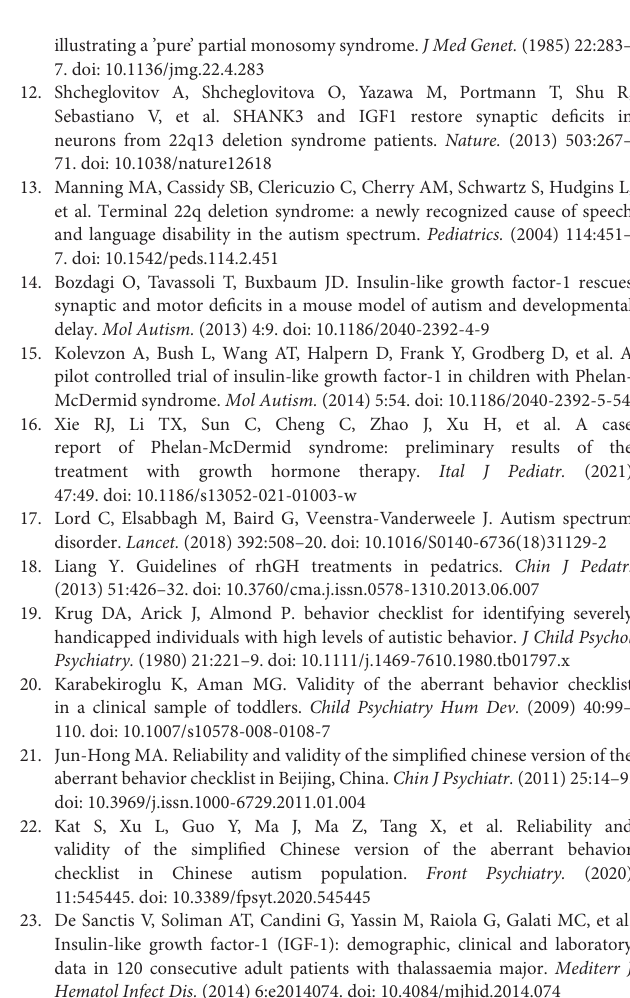
Supplementary File 1 | Simplified Chinese version of the Aberrant Behavior Checklist. Supplementary File 2 | Detailed information of the semi-structured